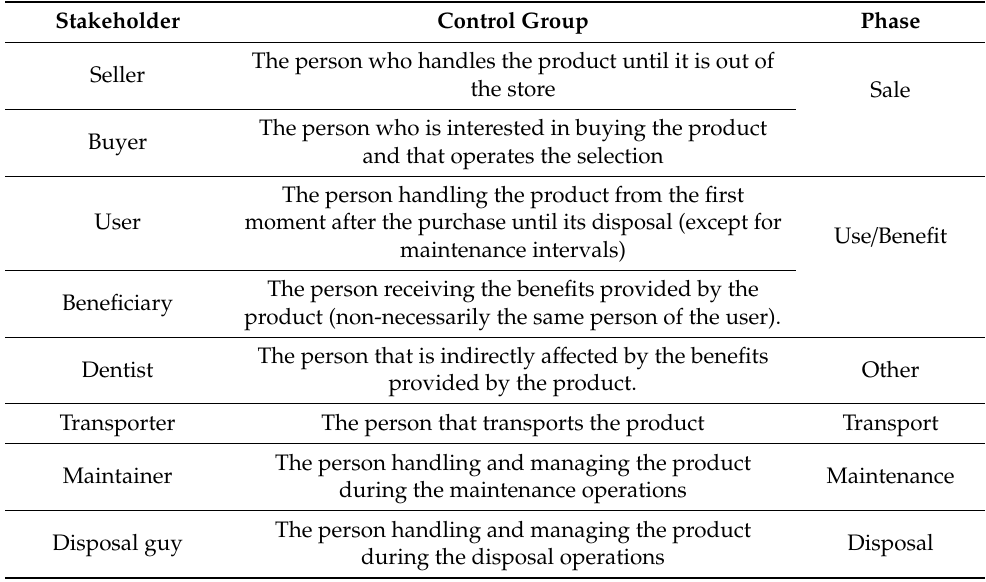
Table 4. The stakeholders identified from the entire set of requirements generated by subjects.